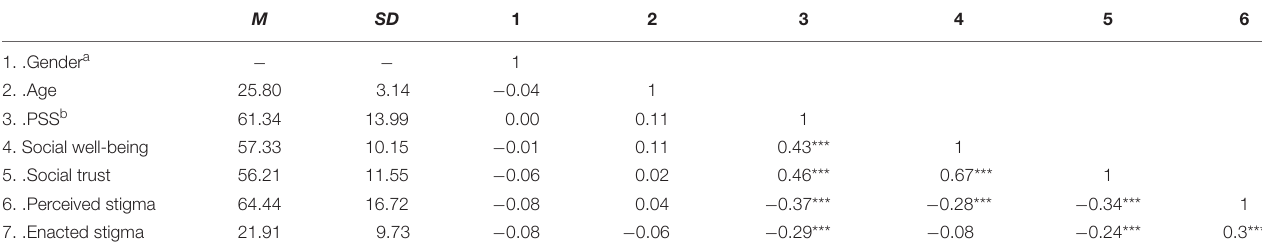
TABLE 2 | Means, standard deviations, and correlations of variables ( N = 297).